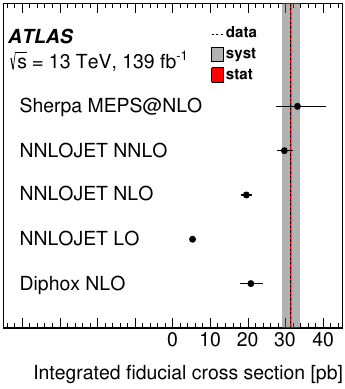
Figure 10. Integrated fiducial cross-section comparison between ATLAS data and theory predic- tions.